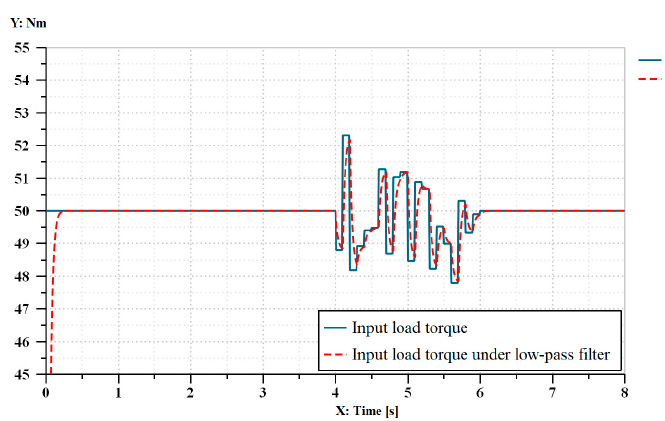
Figure 5. The input torque signal under the single coal hardness.